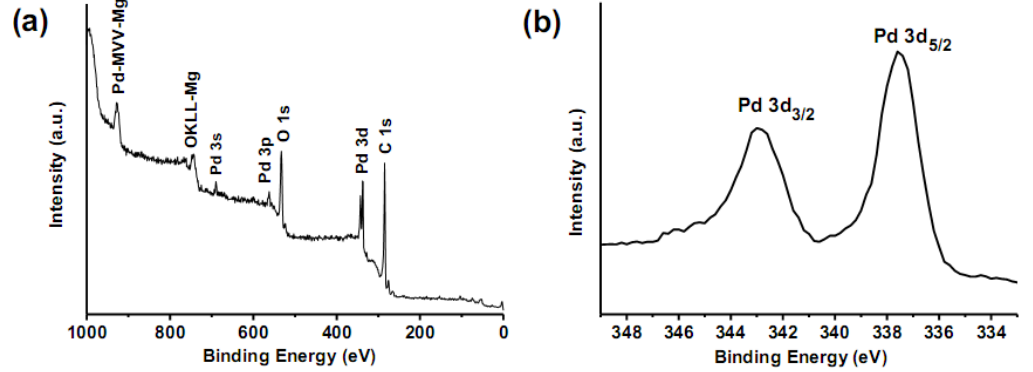
Figure 4. XPS spectra of oMWCNT/PdO: (a) survey of the spectral region from 0 to 1000 eV, and (b) the palladium 3d